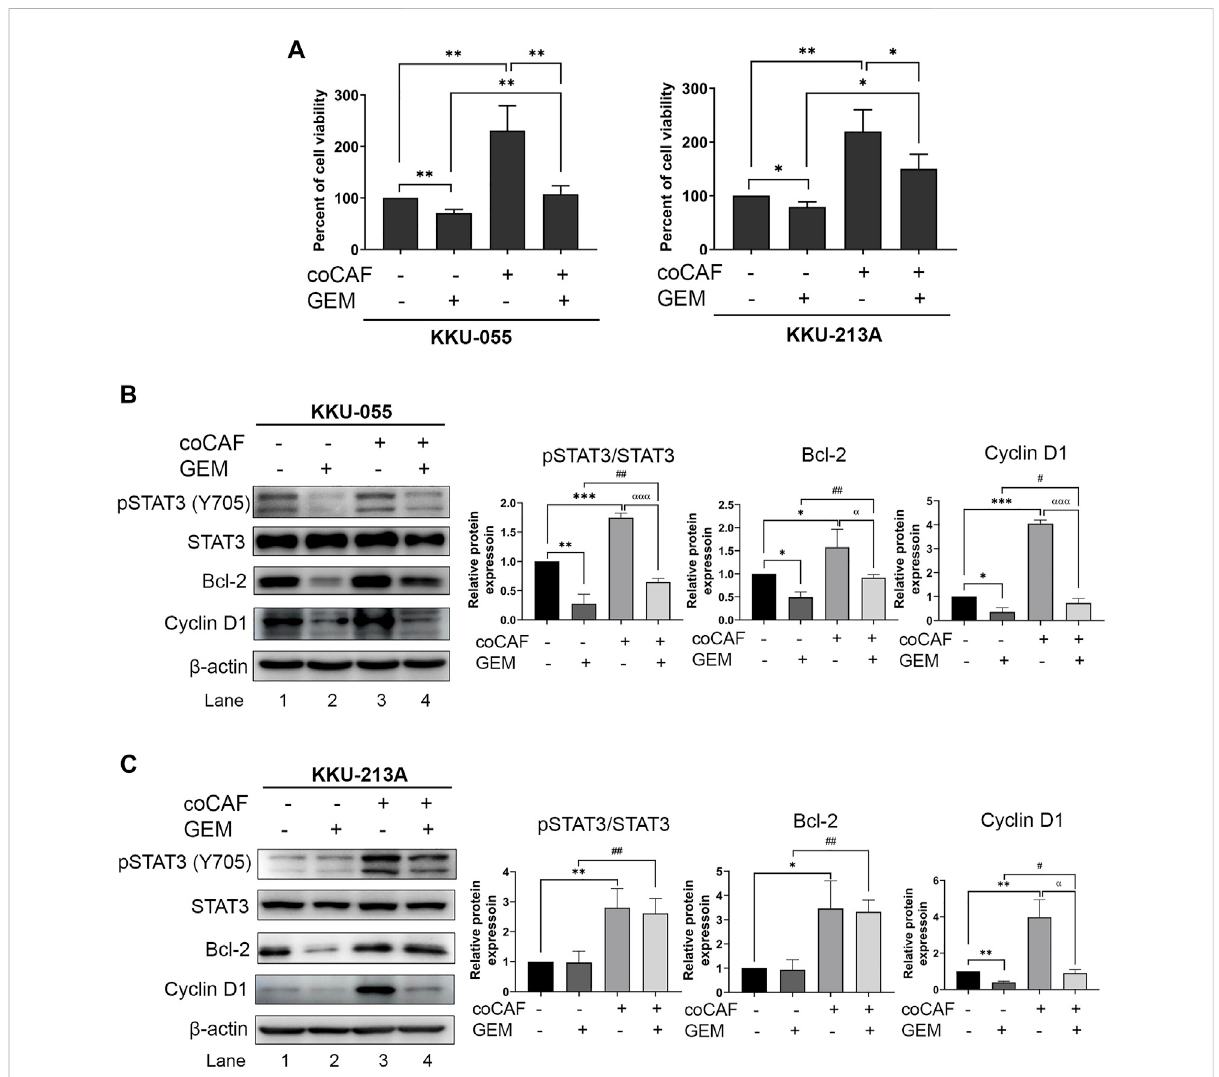
FIGURE 3 The effects of CAFs and molecularchanges on gemcitabine response of CCA cells. (A) CCA cell viability after incubation with and without CAFs and gemcitabine were determined by MTT assay. Western blotting shows the molecular mechanisms of (B) KKU-055 and (C) KKU-213A assessed after monoculture or co-culture with CAFs and treatment with or without gemcitabine. Graphical plots represent the relative protein expressions. Error bars represent the standard deviation (SD) of triplicate experiments. A signi fi cant difference was determined using ANOVA and